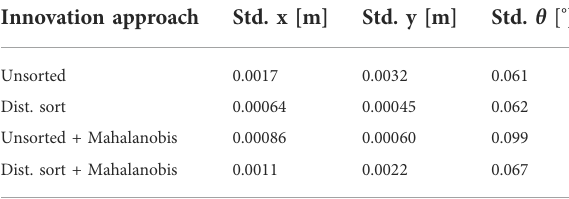
TABLE 4 Standard deviations from the localization system ’ s kidnapped robot tests — permanent. Innovation